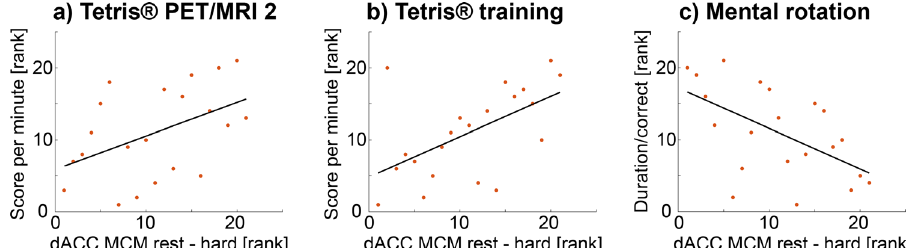
Fig. 4 Associations between MCM adaptations and cognitive performance. Based on the training-induced effects in the salience network (Fig. 3), one would expect that subjects with high MCM values at rest and low values during task execution (i.e., a high divergence between rest and task) show the best cognitive performance after learning. Thus, the difference of MCM values between rest and the hard task condition at the second PET/MRI scan was correlated with task performance. Positive associations of dACC MCM values were observed with the Tetris ® score (high score = high performance) of the second PET/MRI measurement ( a , rho = 0.46, p < 0.05) and that obtained during the 4-week training period ( b , rho = 0.56, p < 0.01, normalized area under curve). Further, dACC MCM values were negatively associated with the mental rotation performance (duration/number of correct answers with low value = high performance, c , rho = − 0.56, p < 0.01). All values were rank transformed to account for one outlier, thus correlation values